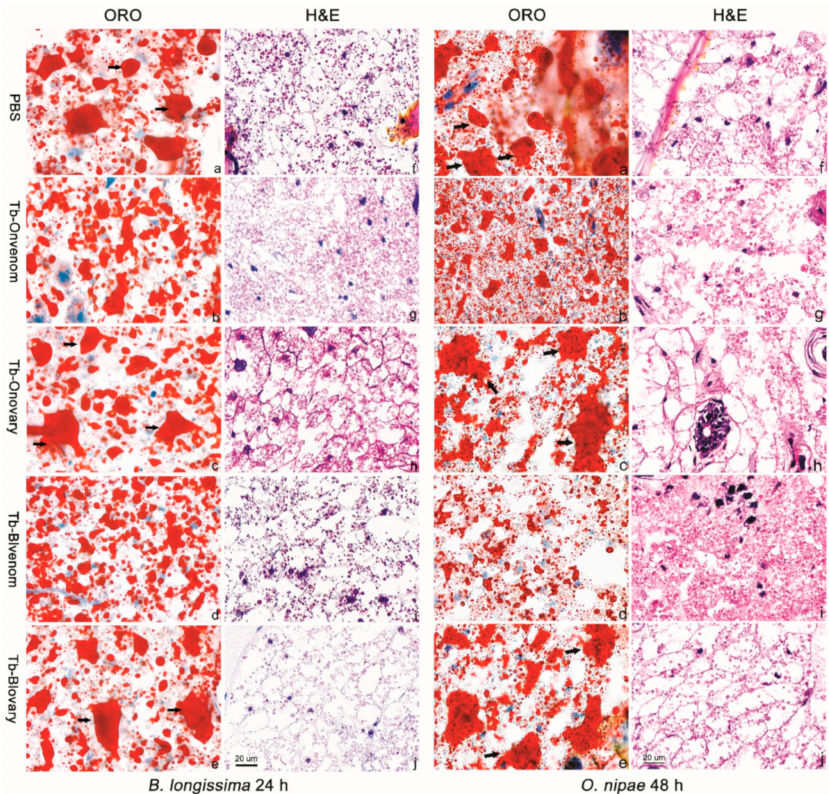
Figure 6. Effect of virulent factors on B. longissima and O. nipae pupae fat body lysis at 24 h and 48 h post injection, respectively. ORO and H&E stained fat body tissues of B. longissima and O. nipae pupae after the injection with PBS ( a , f ), Tb-Onvenom ( b , g ), Tb-Onovary ( c , h ), Tb-Blvenom ( d , i ) or Tb-Blovary ( e , j ); original magnification, 40 × . Larger pieces of fat body are marked by thick black arrows in the ORO sections. Scale bar, 20 µ